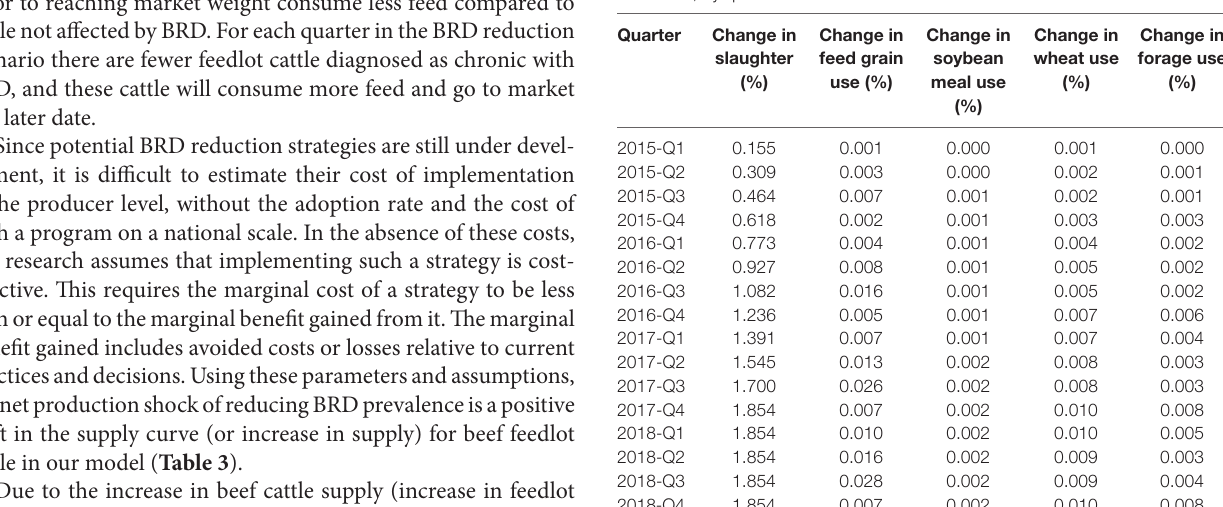
TaBle 3 | Bovine respiratory disease reduction exogenous shocks imposed on the model, by